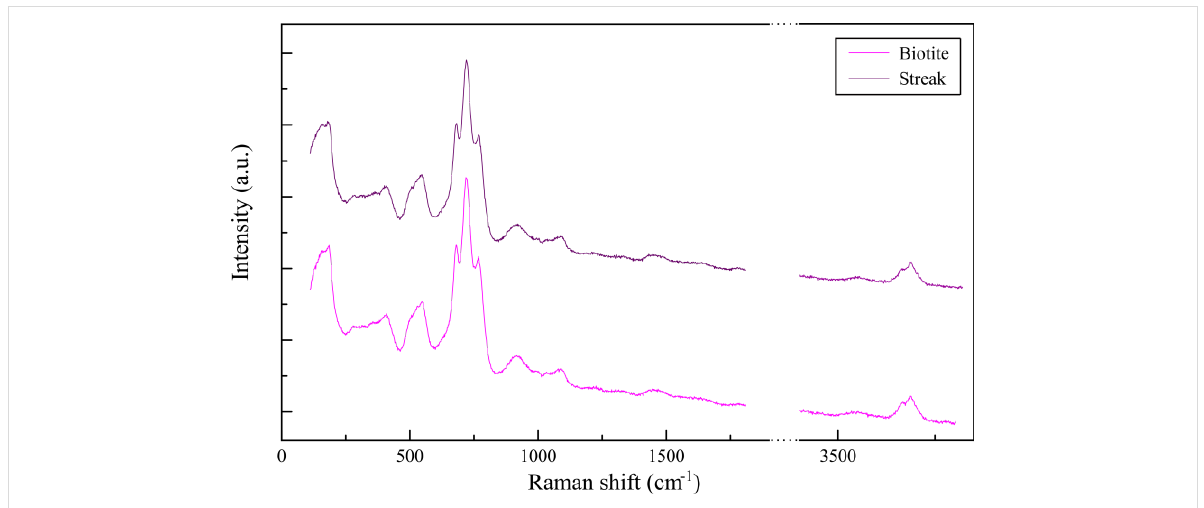
Figure 5: Comparison of characteristic Raman spectra of the (001) biotite surface and that of a streak formed at pH 9.5 and 50 °C. No differences between both spectra are detected.